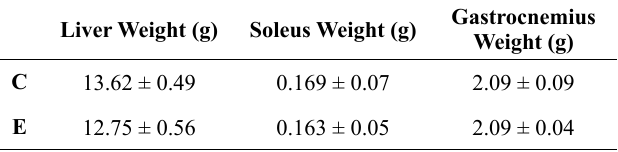
Table 2. Tissue weights from control (C) and exercised (E) groups.